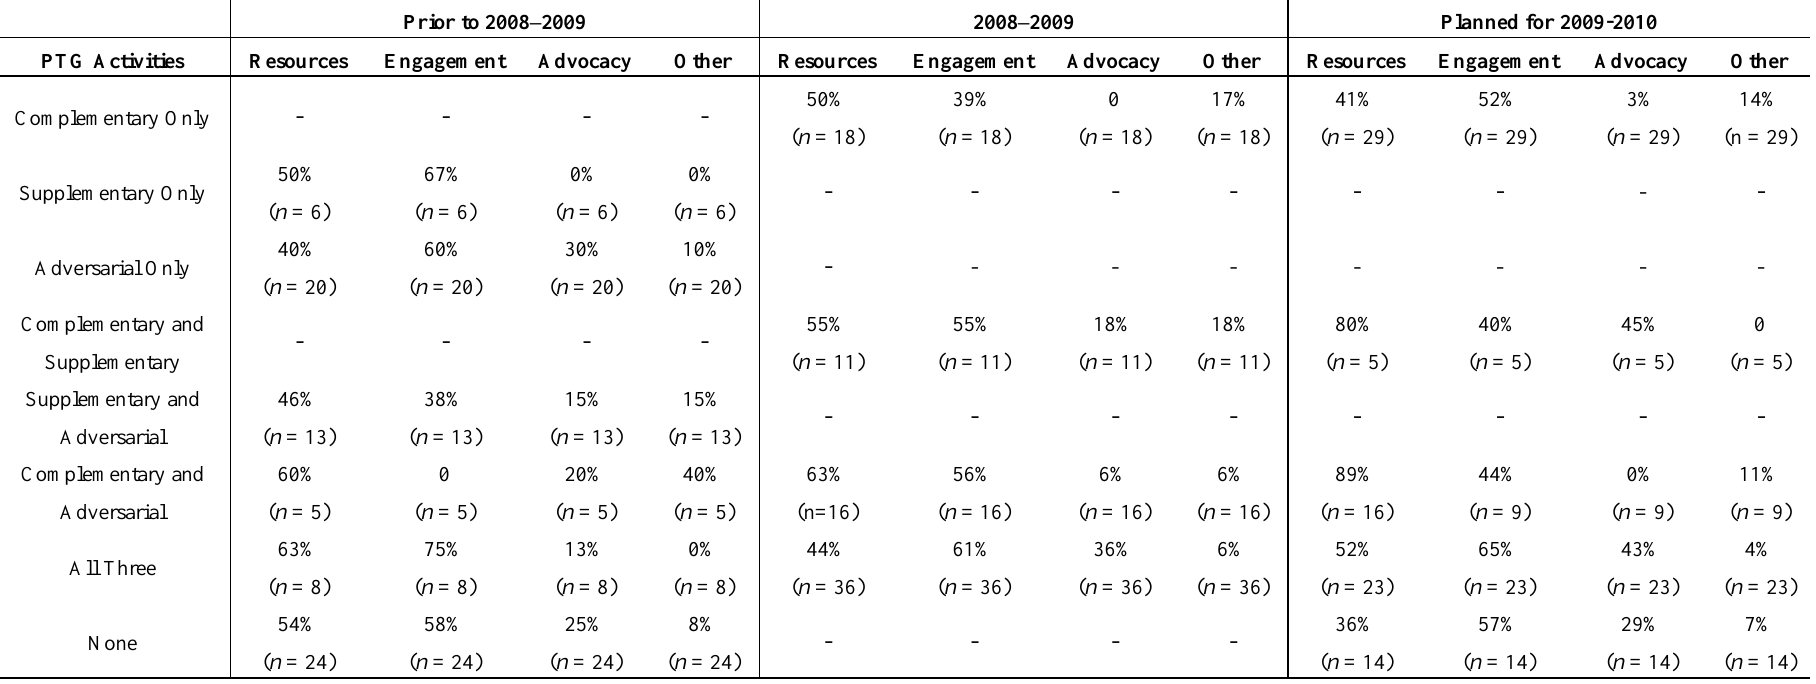
Table 5. Percent PTG mission elements by PTG activities and time